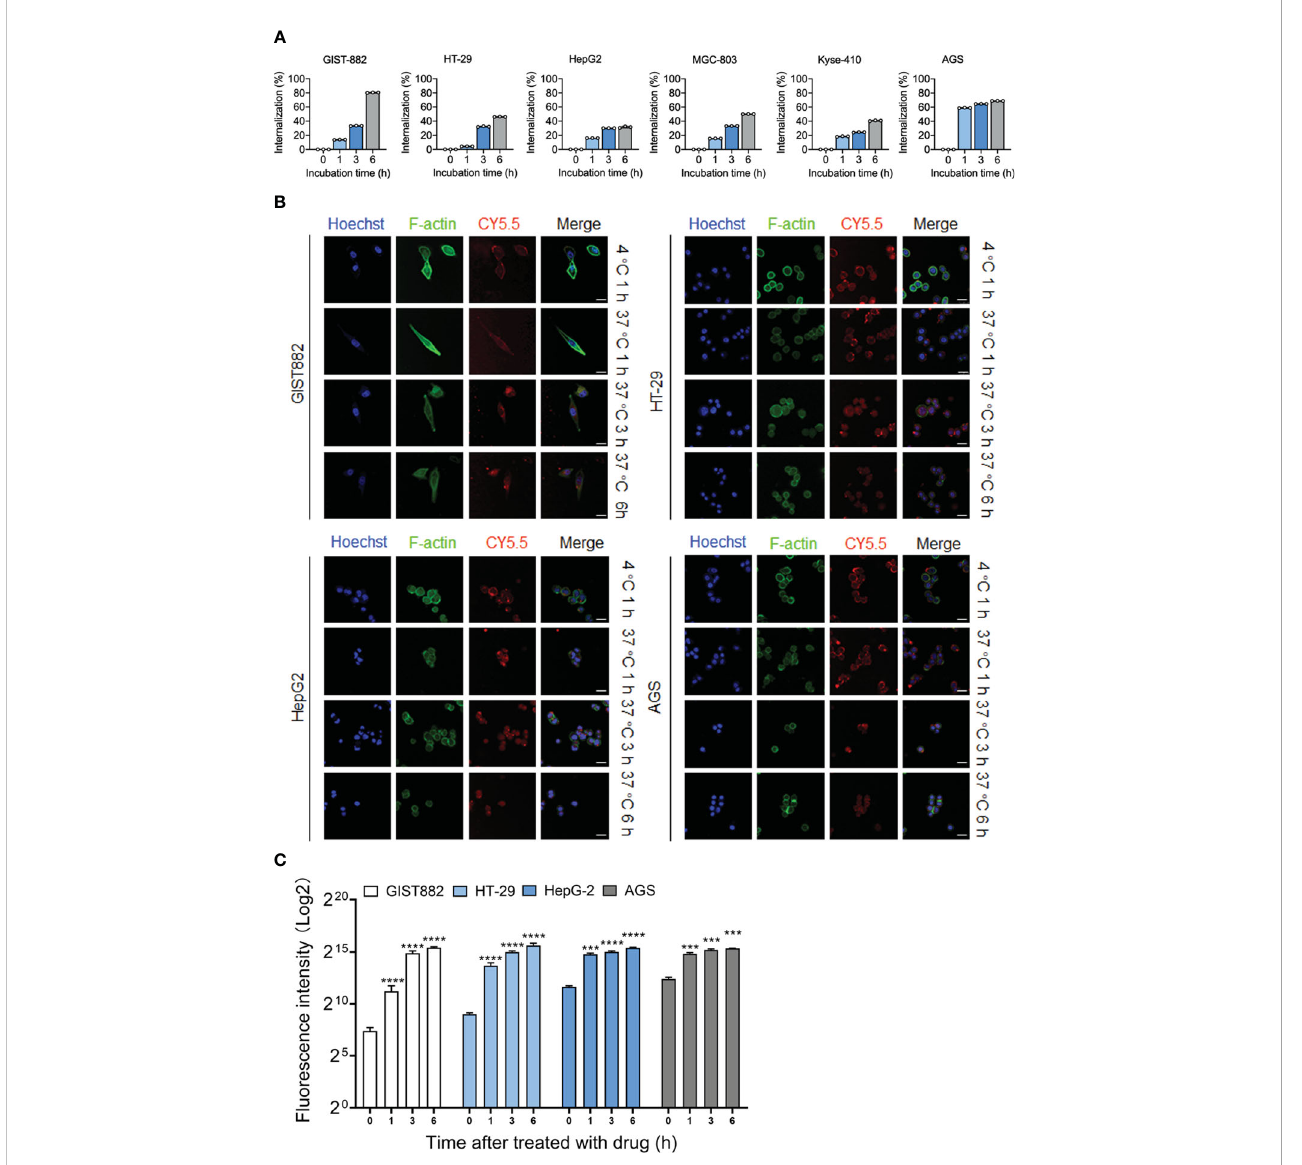
FIGURE 4 DOG1 could mediate the internalization of anti-DOG1 antibodies. (A) The internalization rate of the anti-DOG1 antibody was calculated using the formula [1-MFItime/MFIcontrol]×100%. DOG1 on the cell surface was detected by fl ow cytometry (n=3); (B) Immuno fl uorescence microscopy observation of the endocytosis of Cy5.5-labeled anti-DOG1 DM4 ADC mediated by DOG1 protein in GIST882, HT-29, HepG2, and AGS cell lines. The results are from 0 h, 1 h, 4 h and 8 h. Antibodies were stained with Cy5.5, rhodamine-labeled phalloidin was used to visualize the actin cytoskeleton (green), and Hoechst (blue) was used for nuclear staining. Scale bar, 25 µm; (C) Bar graph showing quantitative analysis of protein expressions internalization rate of the immuno fl uorescence images (n=3). ***, P <0.001; ****, P